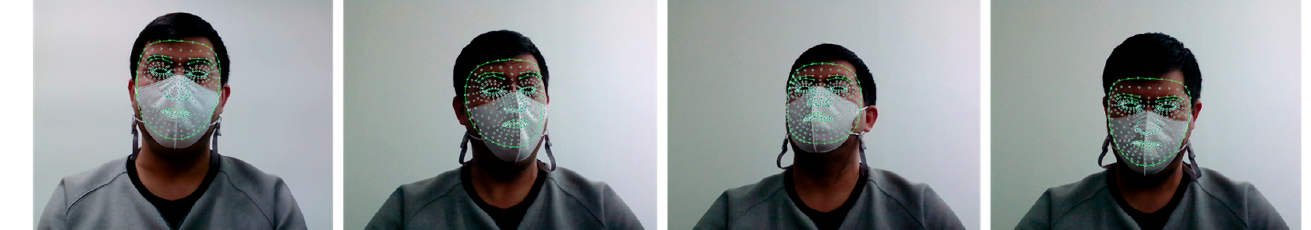
Figure 2. Example of facial landmark images.